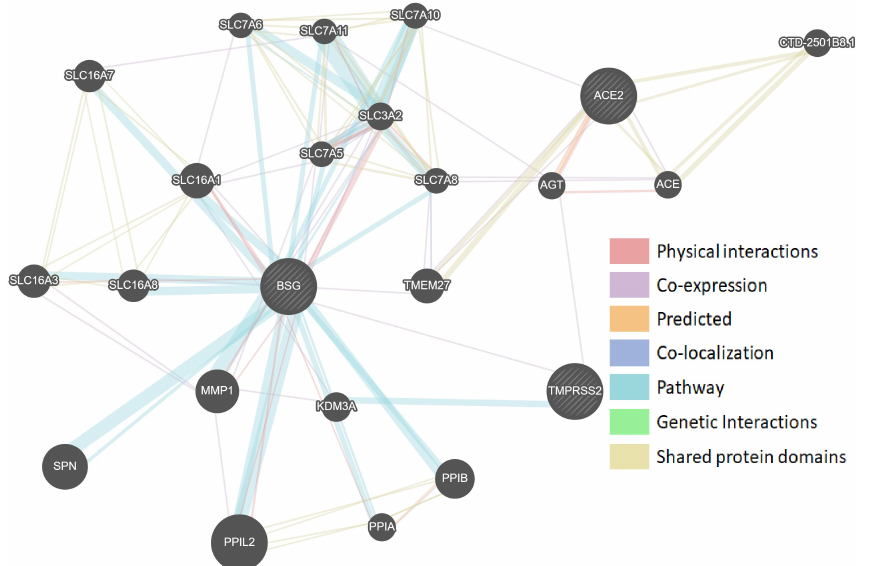
Figure 1. Protein–protein interaction network of SARS-CoV-2-interacting genes (GeneMANIA). The size of the circles indicates the strength of the bond with the gene being